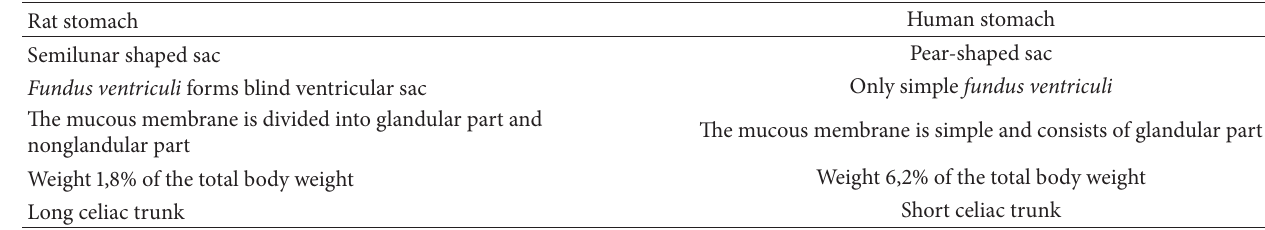
Table 1: Morphological comparison of the rat and human stomach.